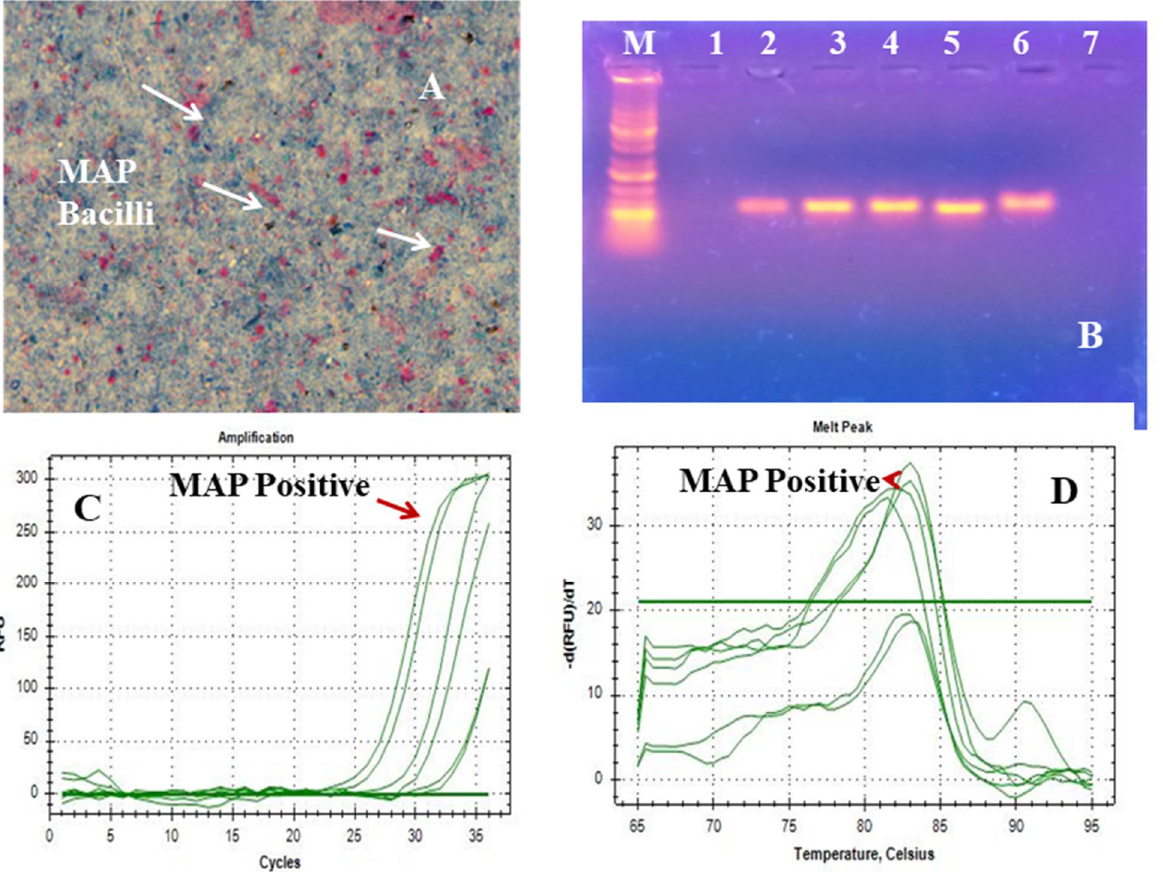
Figure 4. Confirmation of M. paratuberculosis at the molecular level. ( A ) Microscopy (Ziehl-Neelsen stain). ( B ) Conventional PCR ( IS900 413 bp) where Lanes M–7 represents 1 kb DNA ladder, control, positive control, sample 1 (DNA from Solid culture of MAP strain ‘S5’ batch 1), sample 2 (DNA from solid culture of MAP strain ‘S5’ batch 2), sample 3 (DNA from liquid culture of MAP strain ‘S5’ batch 1), sample 4 (DNA from liquid culture of MAP strain ‘S5’ batch 2) and blank respectively. ( C ) Amplification of RT-PCR ( IS900 413 bp); ( D ) Melt Peak of RT-PCR ( IS900 413 bp).